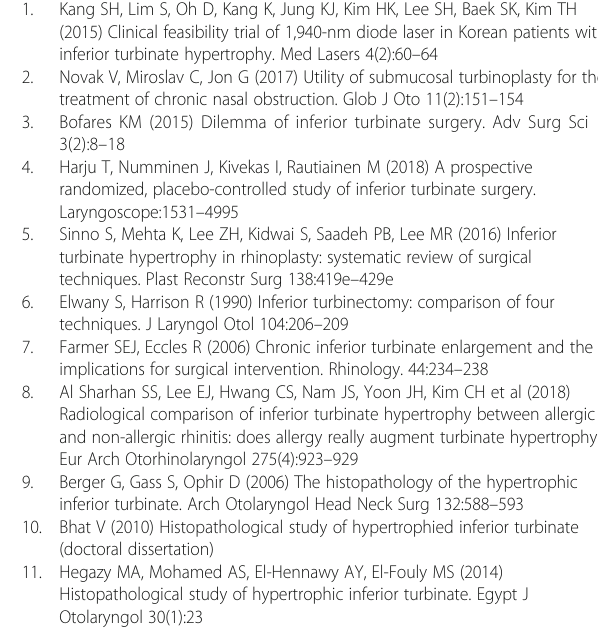
Septoplasty with bilateral turbinectomy